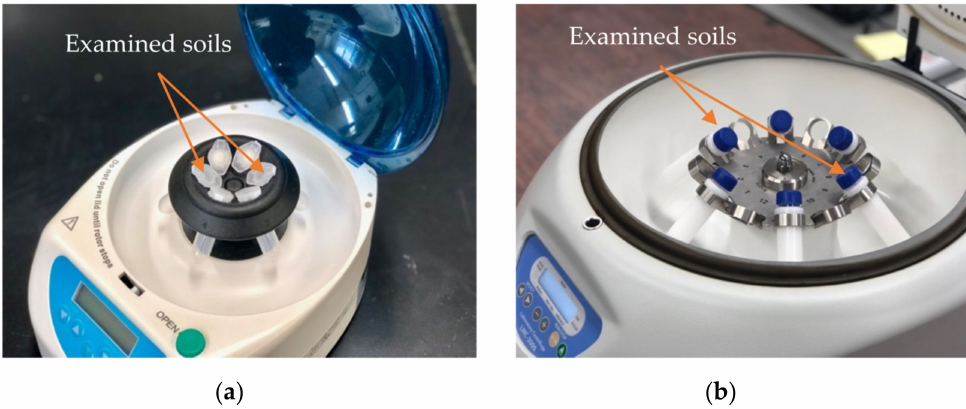
Figure 3. Experimental setup for ( a ) 2 mL and ( b ) 15 mL